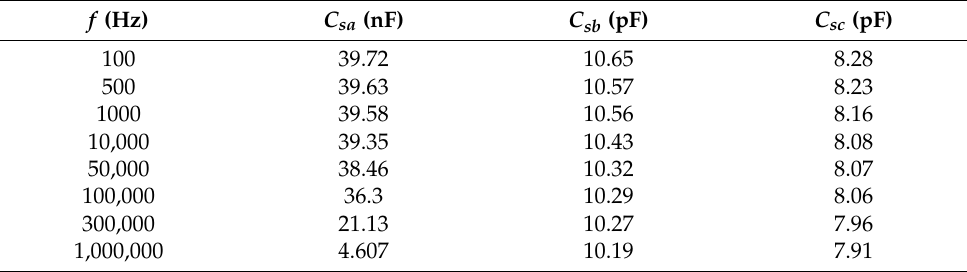
Table 6. Series capacitance test results for LPVT B at 10 V.